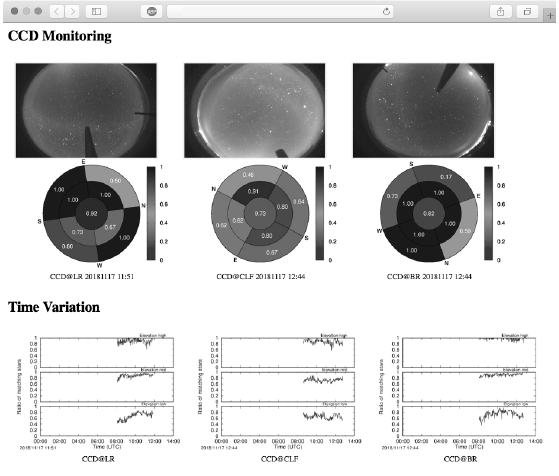
Figure 11: Example of HTML information page. This page update every minutes. Observer can be seen during FD